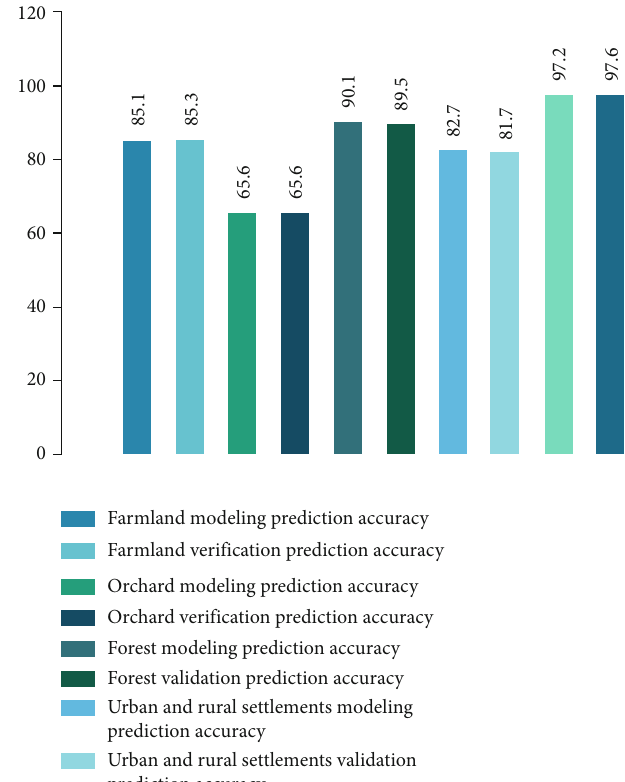
Figure 3: Correct prediction rate of the logistic model for each landscape.